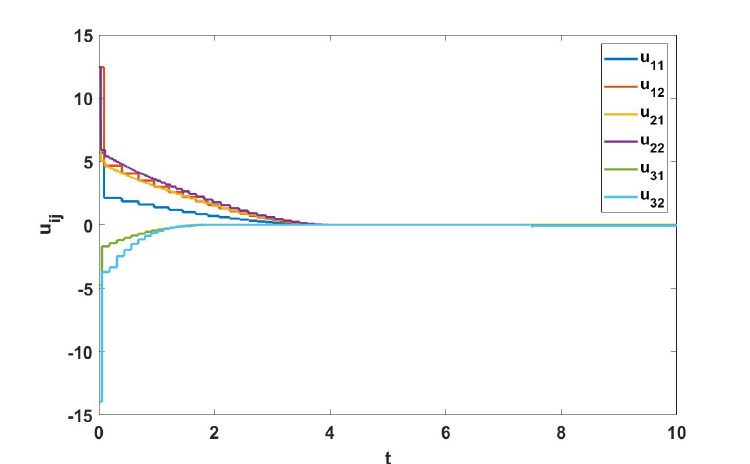
Figure 3. The triggered instants of all followers in Example 1.